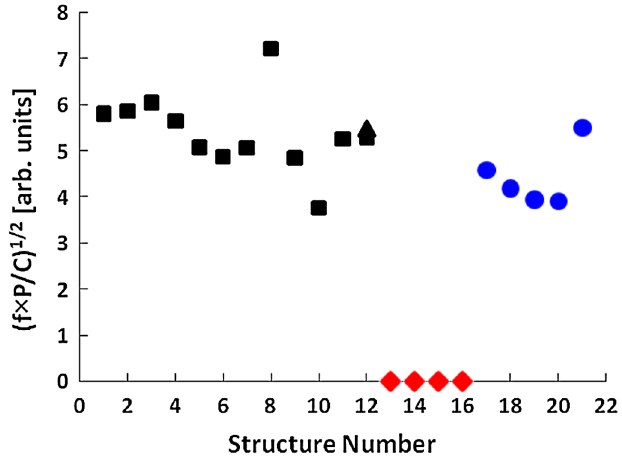
FIG. 6. (Color) Geometry and electric field distribution near a cylindrical tip. Arrows show the direction and color code is proportional to the logarithm of its absolute